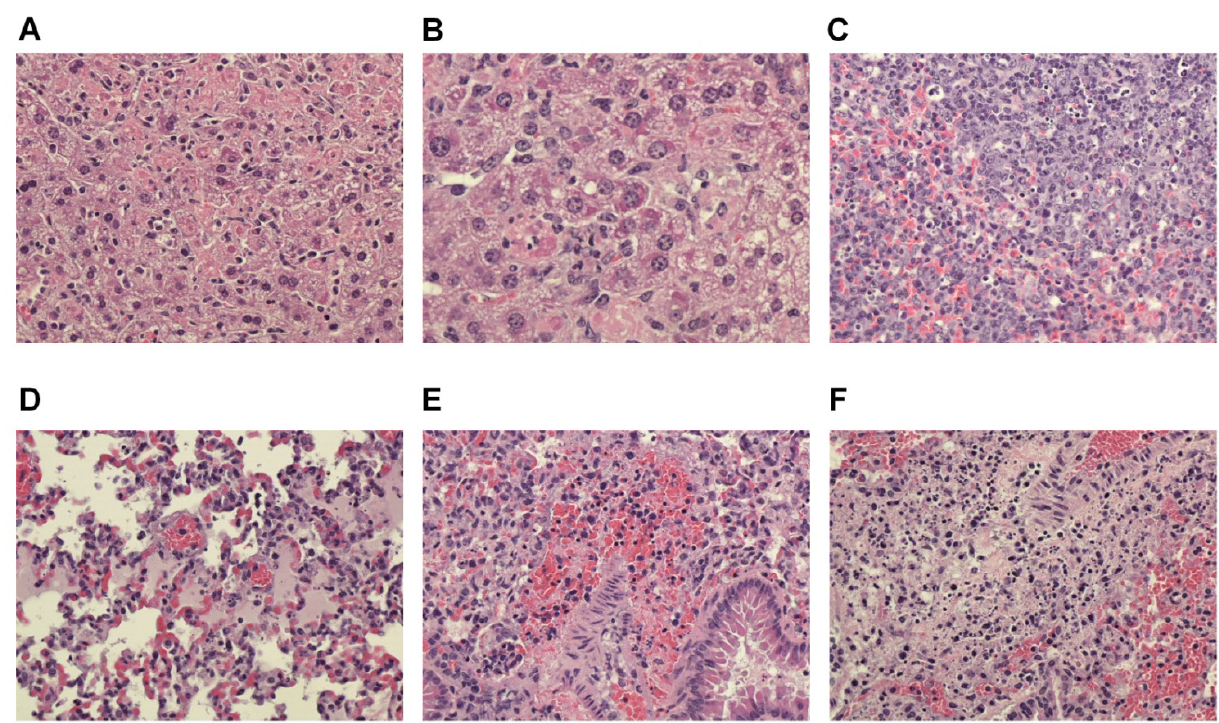
Figure 5. Histopathology in tissues of most susceptible BXD strains after aerosol exposure to a low dose of MA-EBOV. Hematoxylin and eosin (H&E) stained tissues were examined from moribund BXD34 (n = 5) and BXD68 (n = 5) mice. Representative images are shown. ( a ) Section of liver with multiple pale-staining necrotic hepatocytes accompanied by infiltrates of occasional neutrophils. ( b ) Higher magnification of liver showing that, adjacent to areas of necrosis, many hepatocytes contain one or more dark-red intracytoplasmic inclusion bodies. ( c ) Spleen with foci of necrosis in the red pulp (lower left) and white pulp (upper right). Photos D-F are from strain BXD68 lung. ( d ) Pulmonary congestion and edema with scattered necrotic cells within alveolar lumina and lining alveoli. ( e ) Higher magnification showing necrosis of alveolar septa with hemorrhage into the small airways. ( f ) Focus of more extensive alveolar septal necrosis with hemorrhage and low numbers of